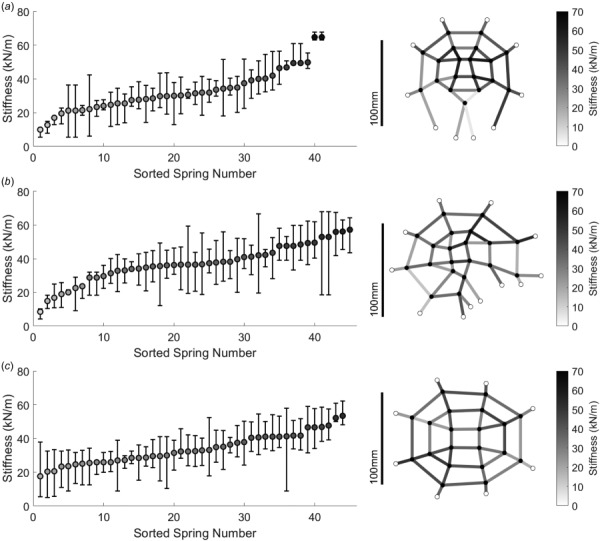
Optimized values of spring stiffness in multibody models. Spring stiffness values for the (a) coronal, (b) sagittal, and (c) axial planes. Springs existing in multiple subdomains were assigned the mean stiffness from subdomain optimization. Springs were color-coded based on spring stiffness and positioned between nodes as displayed in the diagram.